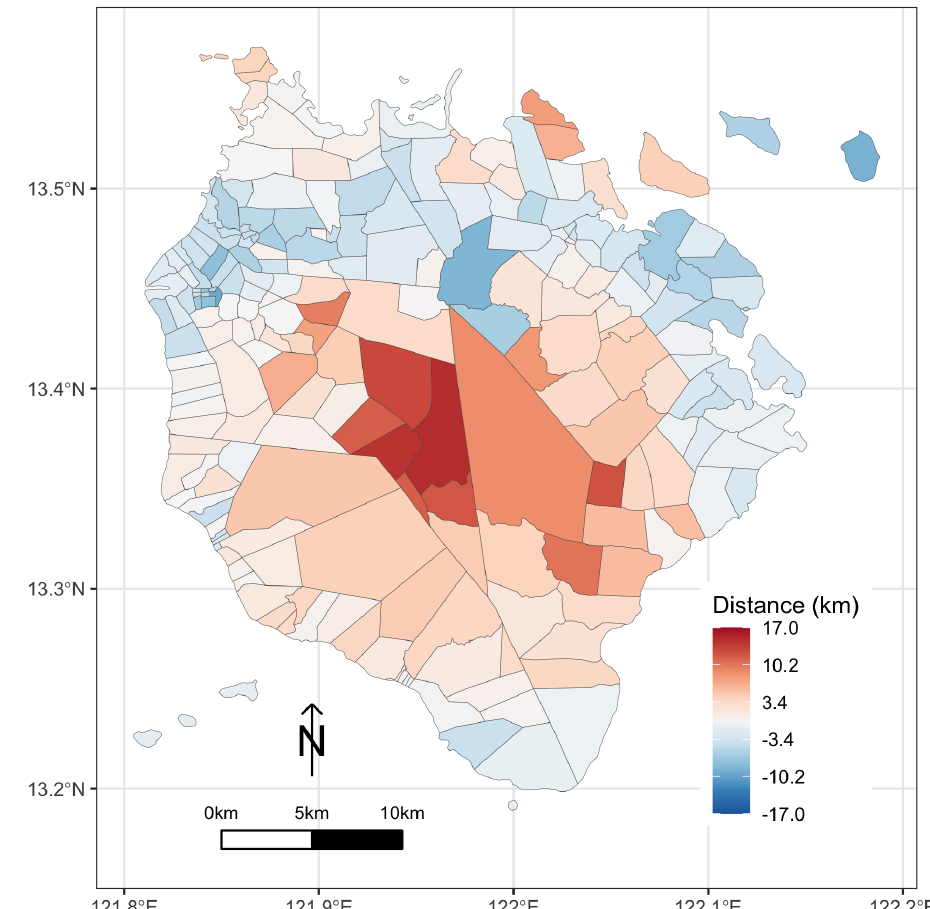
Figure 4. Map of residuals between Google Maps and QGIS generated distance